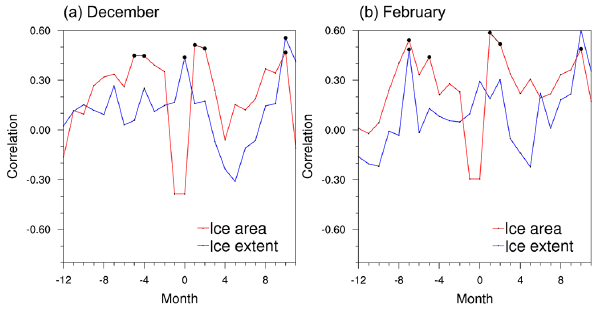
Figure 7. Correlation between monthly averaged Arctic sea ice area and extent with the monthly mean frequency of extreme precipita- tion events in the MENA region for (a) December ( x axis time lag (month), y axis correlation) and (b)